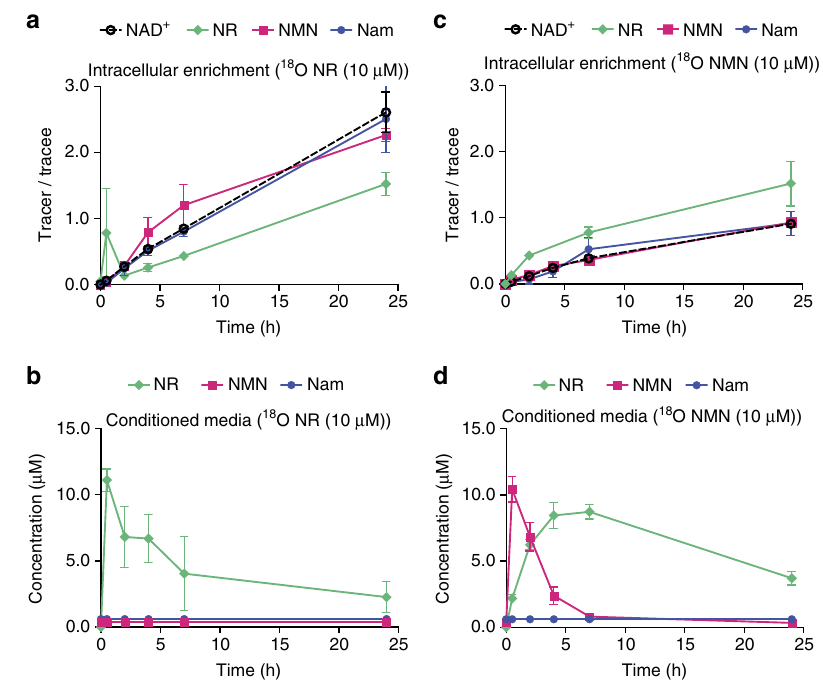
Figure 4 | Extracellular NMN dephosphorylates to NR. HepG2 cells were treated with [ 18 O]-labelled NR ( a , b ) or NMN ( c , d ). Intracellular enrichment of labelled compounds ( a , c ) and presence of labelled compounds in the media of treated cells ( b , d ). Results shown are mean ± s.e.m. ( n ¼